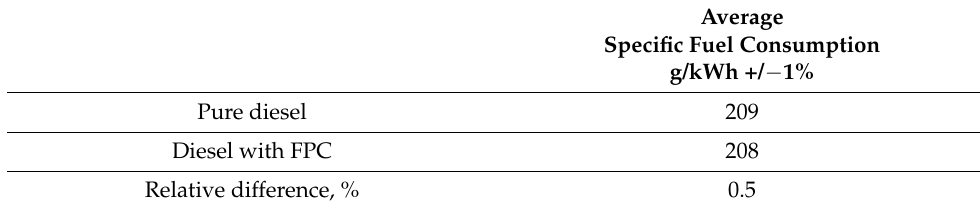
Table 6. Average specific fuel consumption for fuel tested.